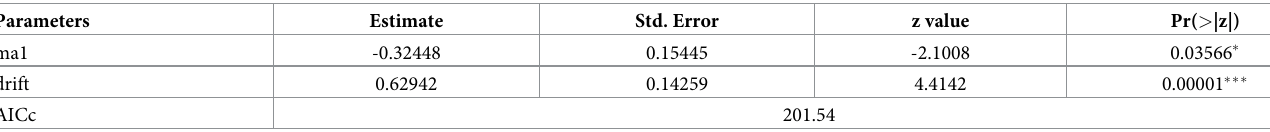
AICc: Corrected Akaikes Information Criteria Std. Error: Standard Error ARIMA: Autoregressive Integrated Moving